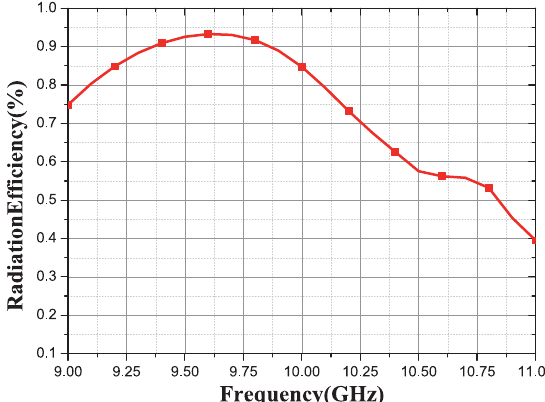
Fig. 12. The radiation ef fi ciency of the antenna 1.